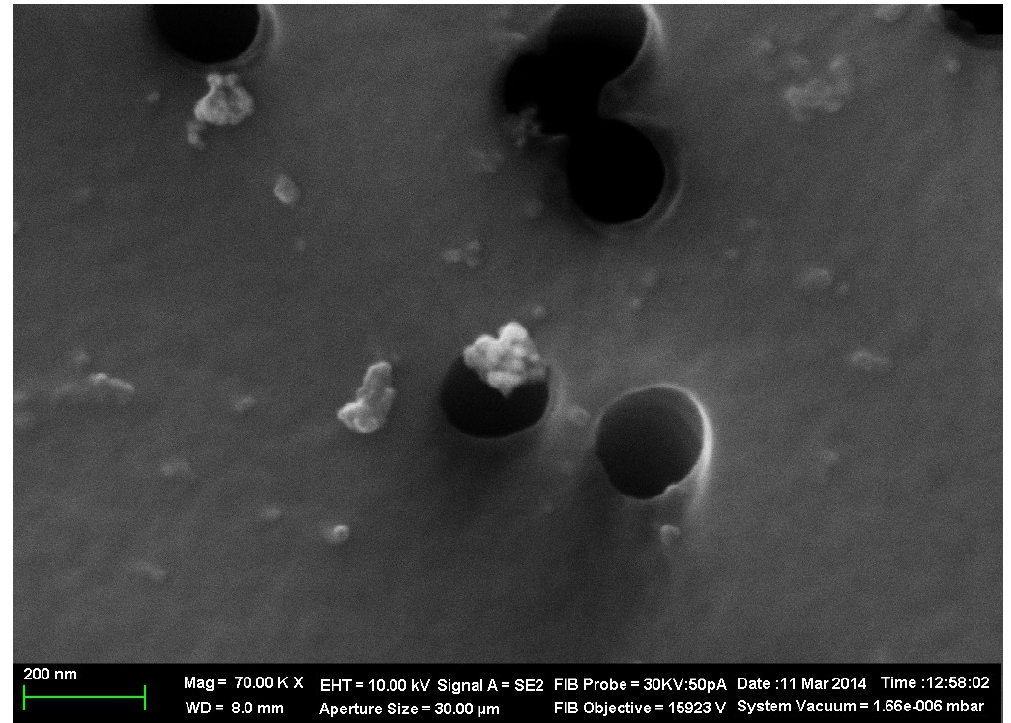
Figure 1. Sinle and aggregated particles sampled on a polycarbonate filter from the ambient air of a cathode copper smelting and casting facility. Scanning electron microscopy, magnification ×70,000 (black spots are filter’s pores).